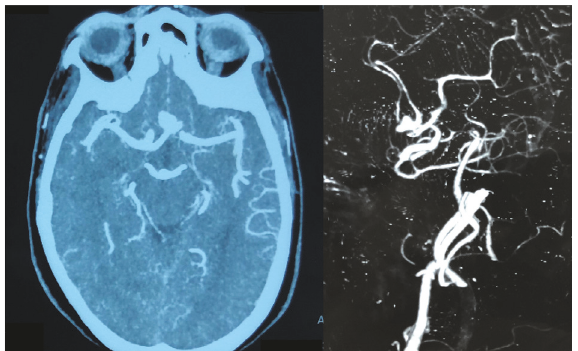
Figure 2: Computed Tomogram Angiography films showing the anterior communicating artery aneurysm.